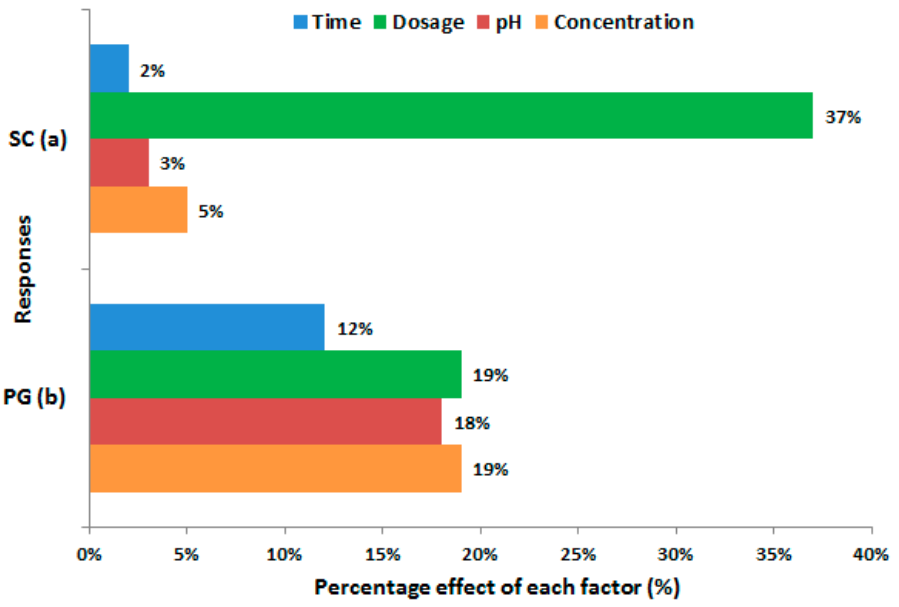
Figure 5. Pareto chart analysis for ( a ) SC and ( b ) PG.